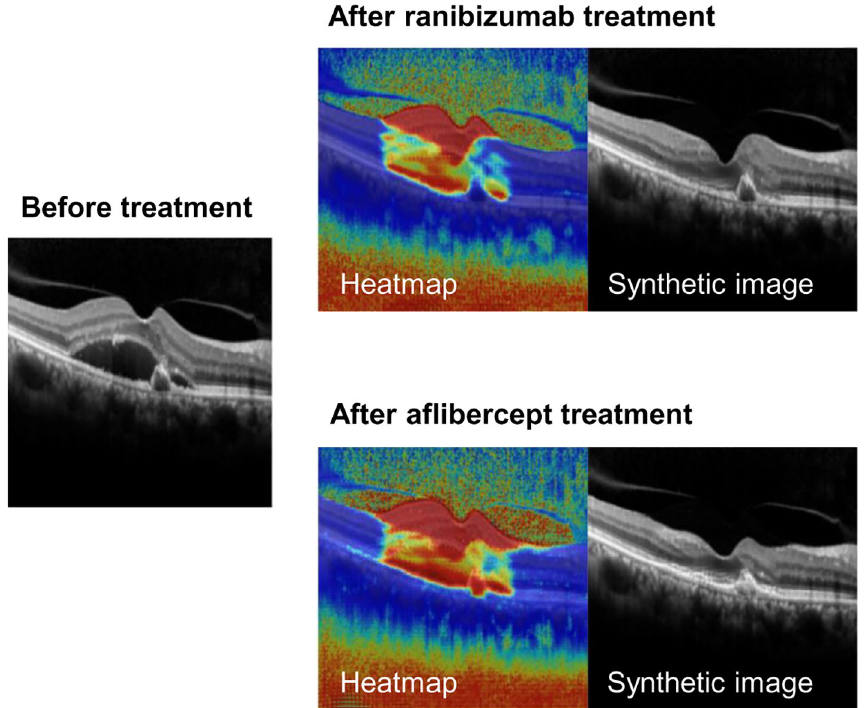
Figure 6. A representative figure of heatmap images shows that the artificial intelligence model identifies pathologic lesions of the retina. Additionally, there is a difference in heatmap images between ranibizumab and aflibercept